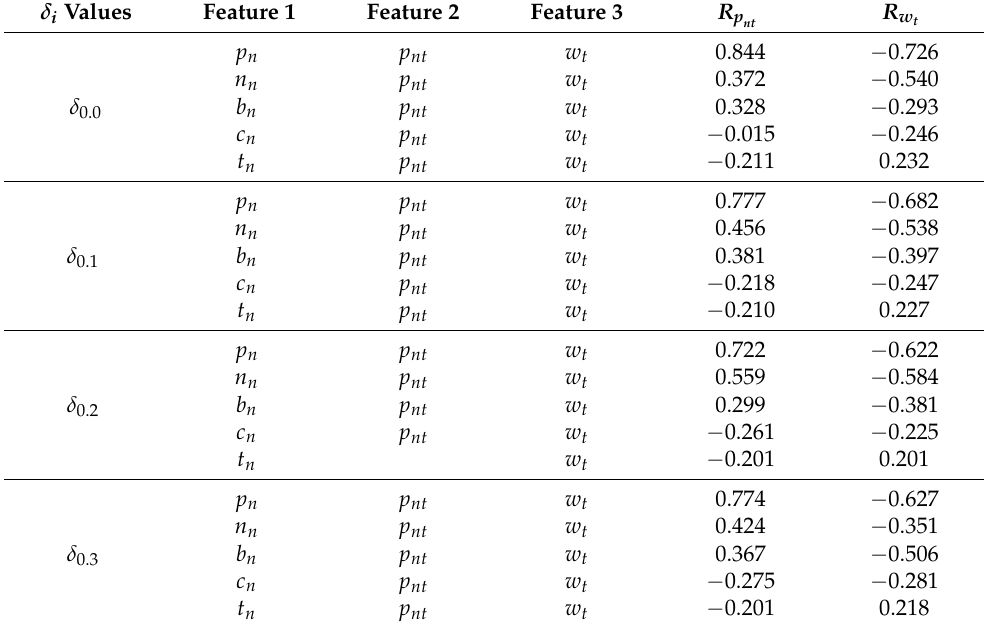
Table 5. Correlation values between variables according to the δ i values.